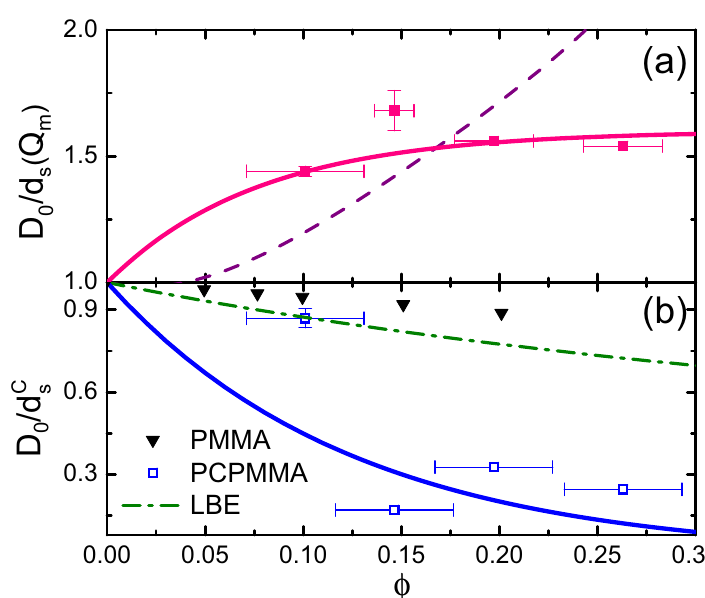
Figure 4. ( a ) The (reciprocal of the) short-time diffusion at q = Q m demonstrates the lifetime of structural fluctuations, with a wavelength corresponding to the interparticle separation. The data, obtained for our PCPMMA fluids by ConDDM ( pink squares), are shown for a range of different φ . A polynomial fit to the hard PMMA spheres’ data [21] obtained by DLS (see main text), is shown by a dashed curve. ( b ) The (reciprocal of the) short-time collective diffusion (the limiting behavior at q → 0) exhibits a very steep φ -dependence for our charged PCPMMA spheres (open blue squares, obtained by ConDDM). A much less steep behavior was previously obtained for the hard PMMA spheres [21], employing DLS ( black triangles). The theoretical prediction for the hard spheres (dash-dotted curve, marked as LBE [fluctuating lattice Boltzmann equation method]) [21,43,44] does not match either of the experimental dependencies. The solid lines are guides to the eye. Note, in contrast with the common intuition, both the experimental and the theoretical rates of collective diffusion speed up with φ